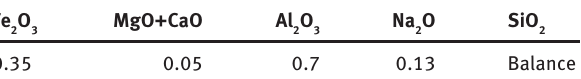
Table 1: Chemical composition of SiO (wt.%).